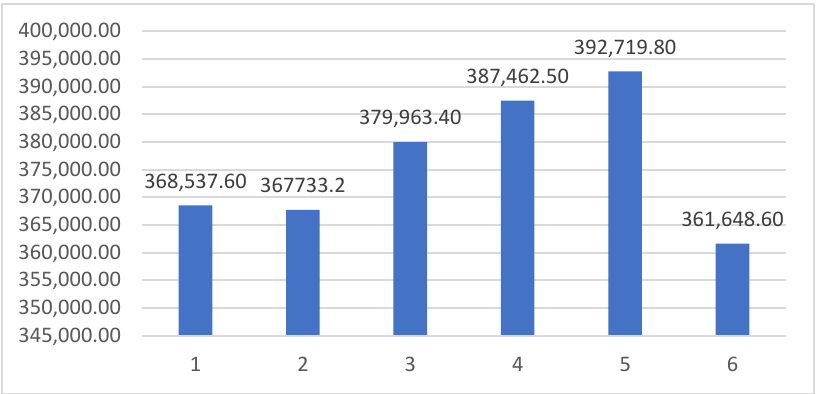
Figure 18. Total cargo flow in ports of the eastern coast of the Baltic Sea in 2015 – 2020 (thousand tons). During the analyzed period, the total cargo flow steadily increased till 2019. However, comparing the total cargo flow in 2020 with that of 2015, a decrease of 1.9 percent was observed and compared to 2019; the total cargo handling in ports of the eastern coast of the Baltic Sea decreased by 7.9